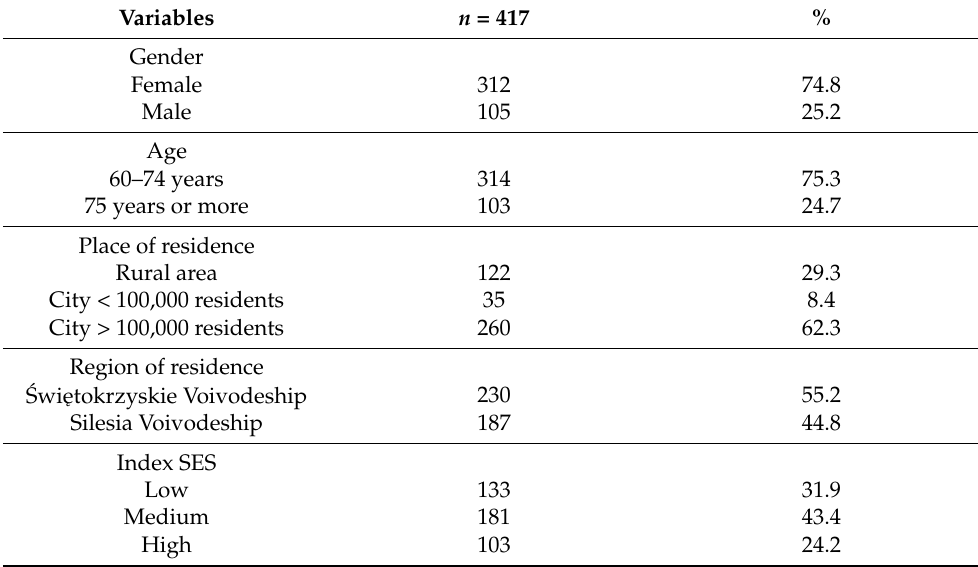
Table 1. Study sample